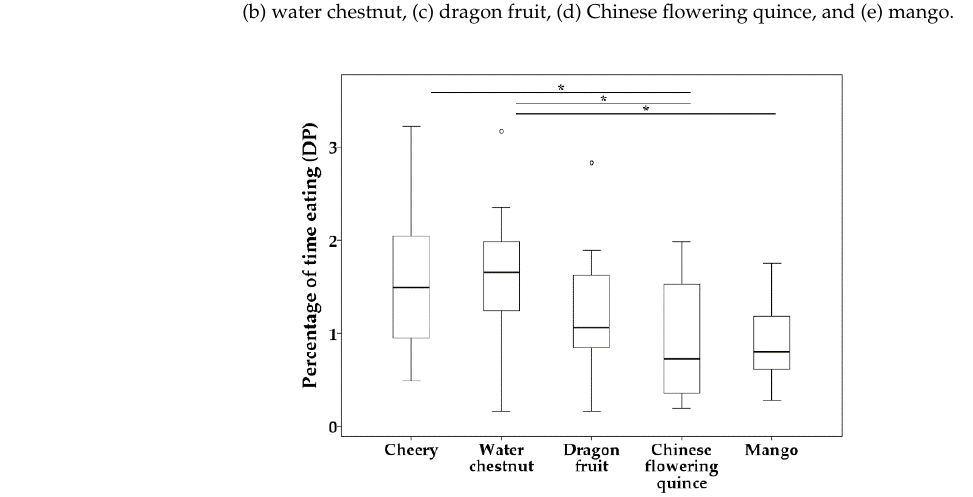
Figure 3. Boxplots of influence of novel food type on percentage of time eating during 30 min (DP). Bars show the maximum observed value (upper part) and the minimum observed value (lower part). Line and asterisk(s) above the boxplots indicate statistically significant comparisons between the two groups. Upper edge of the box shows the upper quartiles (Q3), while the lower edge of the box shows the lower quartiles (Q1). The middle line in the box shows the median. Abnormal values are shown as small circles for outliers above the boxplots but under the line. * p <